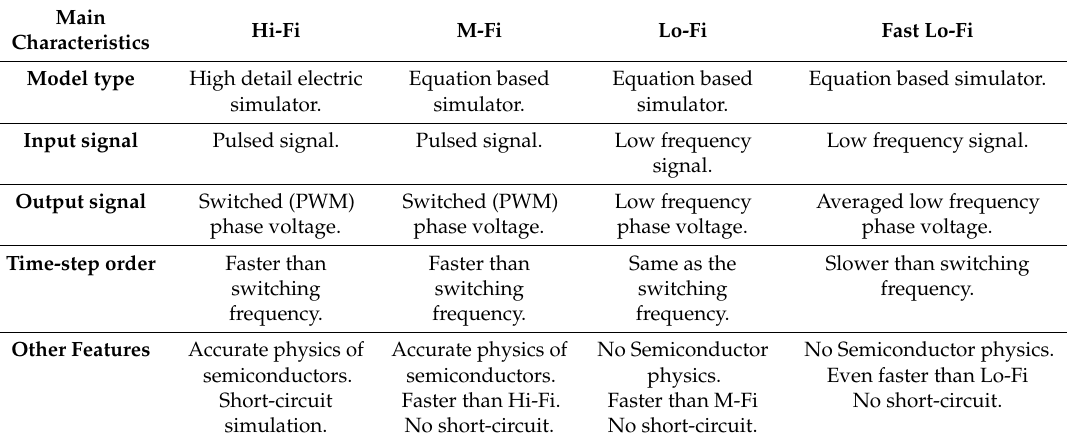
Table 1. Summary table of the four different models.